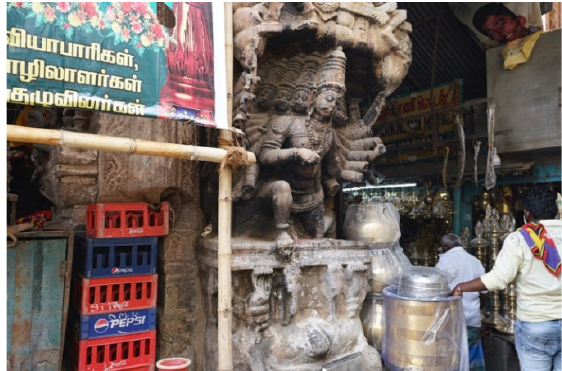
Figure 6. Madura. Trimul Naik's Portico [Pudu Mandapa]. Pillar at S.W. corner of building